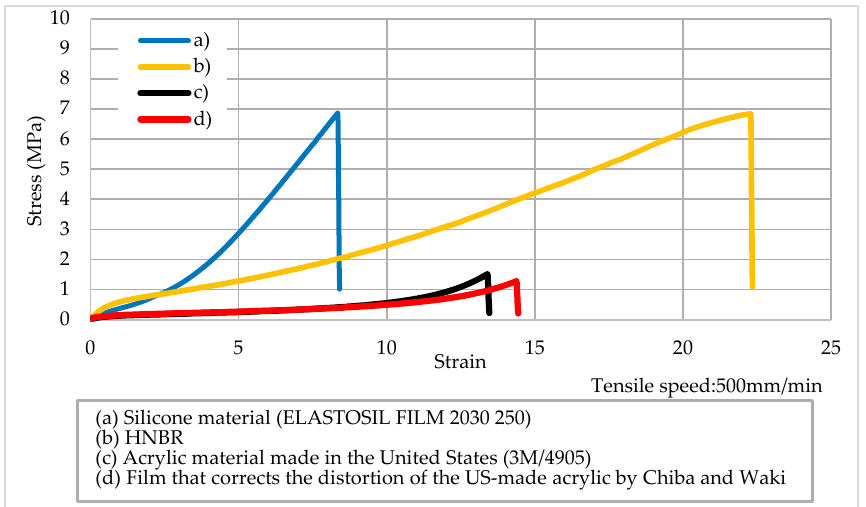
Figure 20. The results of SS curves of (a) the silicon (ELASTOSIL FILM 2030 250, shown in blue), (b) the HNBR ver.3 (orange line), (c) the acrylic material made in the United States (3M/4905, shown in black), and (d) the film that corrected the distortion of the U.S.-made acrylic (red line).